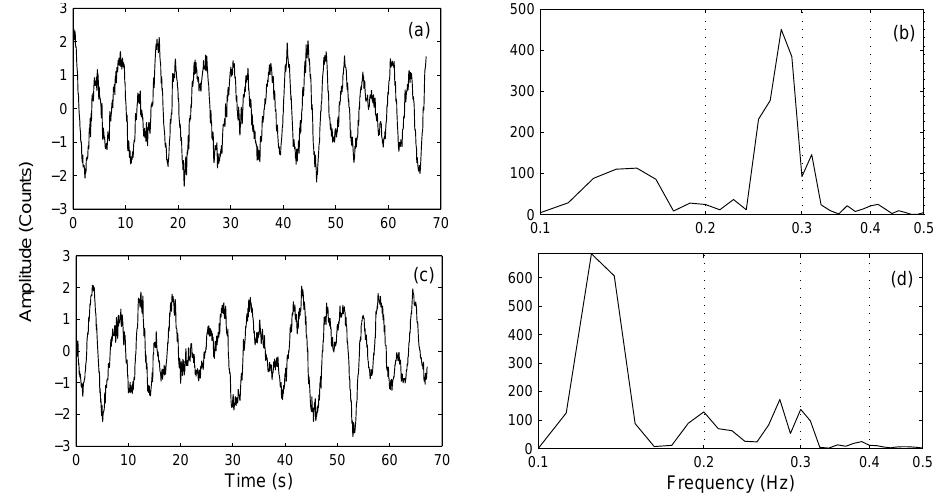
Fig. 14. Independent components of the Colima background seismic signal in time (a, c) and frequency (b, d) domain (from Cusano and Palo,